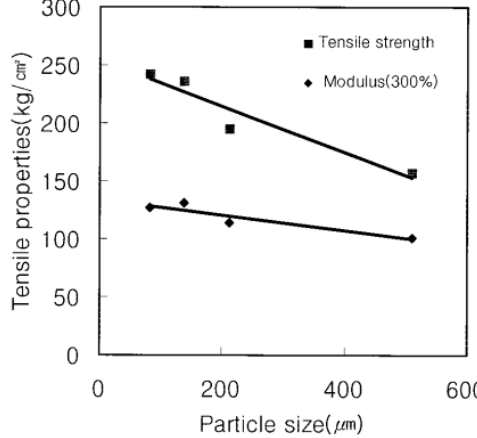
Figure 28. Tensile properties of SBR / GTR compounds as a function of GTR particle sizes at 30 phr (reproduced with permission from [119]).